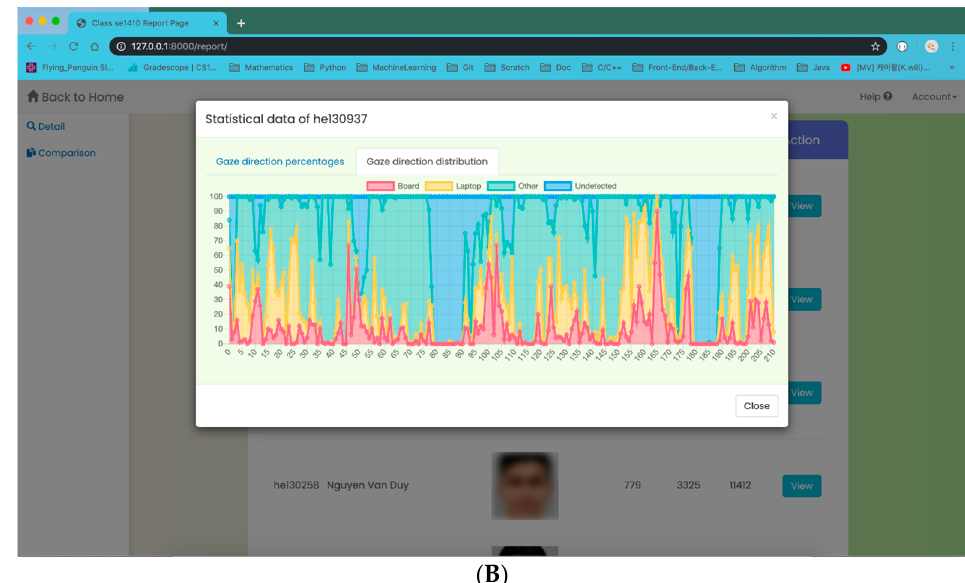
Figure 8. ( A ) The pie chart shows the numerical proportion of gaze direction data during the class; ( B ) the area chart represents cumulated total number of appearances of gaze classes over time.